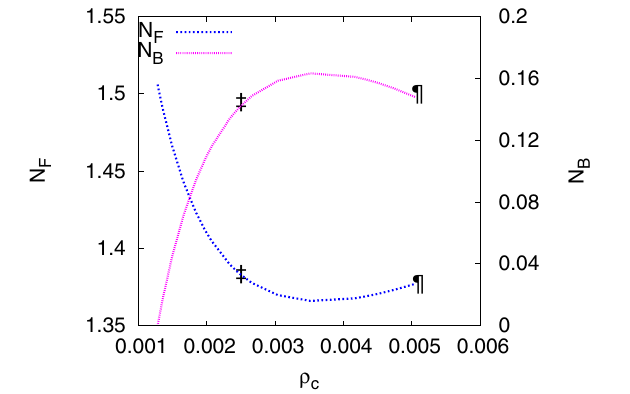
Fig.8 Initialdataofamixedfermion–bosonstarwithfixedtotalmass M T = 1 . 4.Thenumbersoffermions, N F , and bosons, N (denoted N B in the figure, but just N in this text), in terms of the central density, ρ c , are plotted. The position of the maximum of N (and correspondingly the minimum of N F ) represents